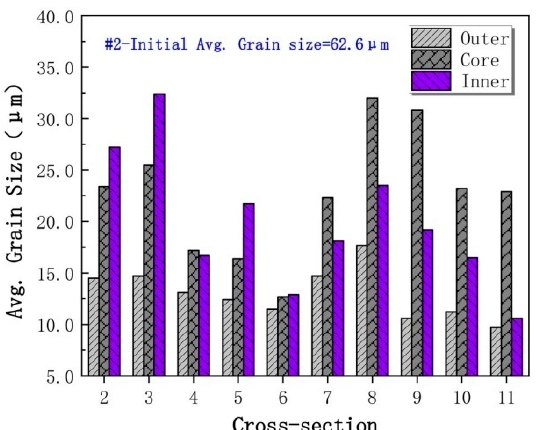
Figure 19. Average grain size at different cross-sections in No. 1 rolled piece [23] (Reprinted from ref. [23]).